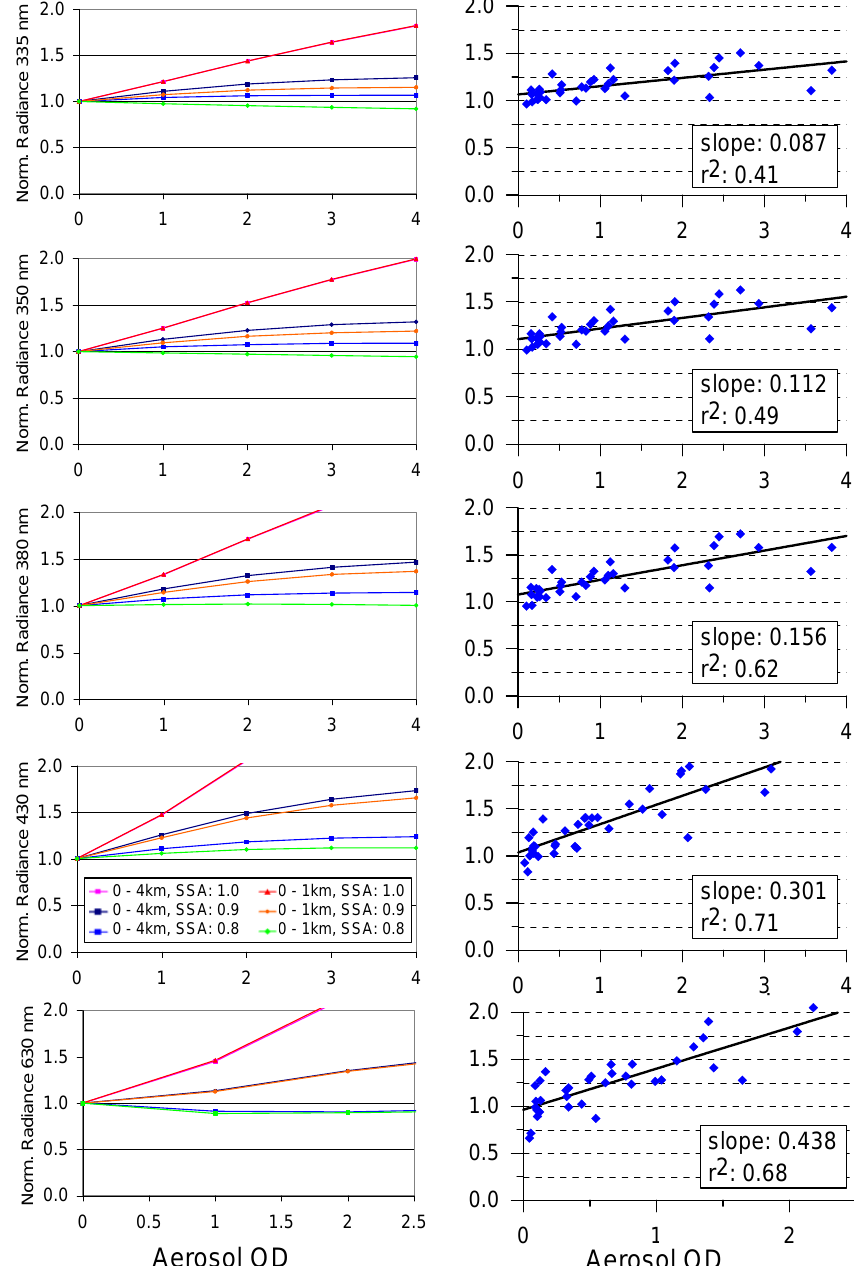
Fig. 11. Observed (right) and simulated (left) dependence of the normalised radiance on the AOD. The data are normalised to the values modelled for an AOD of 0 (see text). The calculations are performed for SZA of 30 ◦ and a viewing angle of − 90 ◦ (nadir). The aerosol asymmetry parameter was assumed to be 0.68. For 630 nm the surface albedo was set to 10%; for all other wavelengths it was set to 5%. the slope of the modelled dependencies strongly depends on The comparison of observations and simulations again in- the varied aerosol properties, single scattering albedo and dicates that the aerosol over Beijing is typically weakly ab- layer height. For short wavelengths, an increase of the Ring sorbing (SSA ≈ 0.9). However, it should be noted that no effect is even found for purely scattering aerosols at low al- exact agreement is expected because the simulations were titude. In contrast, for large wavelengths a decrease of the performed for fixed viewing geometry (SZA: 30 ◦ , viewing Ring effect is found for all assumed aerosol scenarios. angle: − 90 ◦ – nadir), while the satellite instrument’s obser- vation geometry varies with